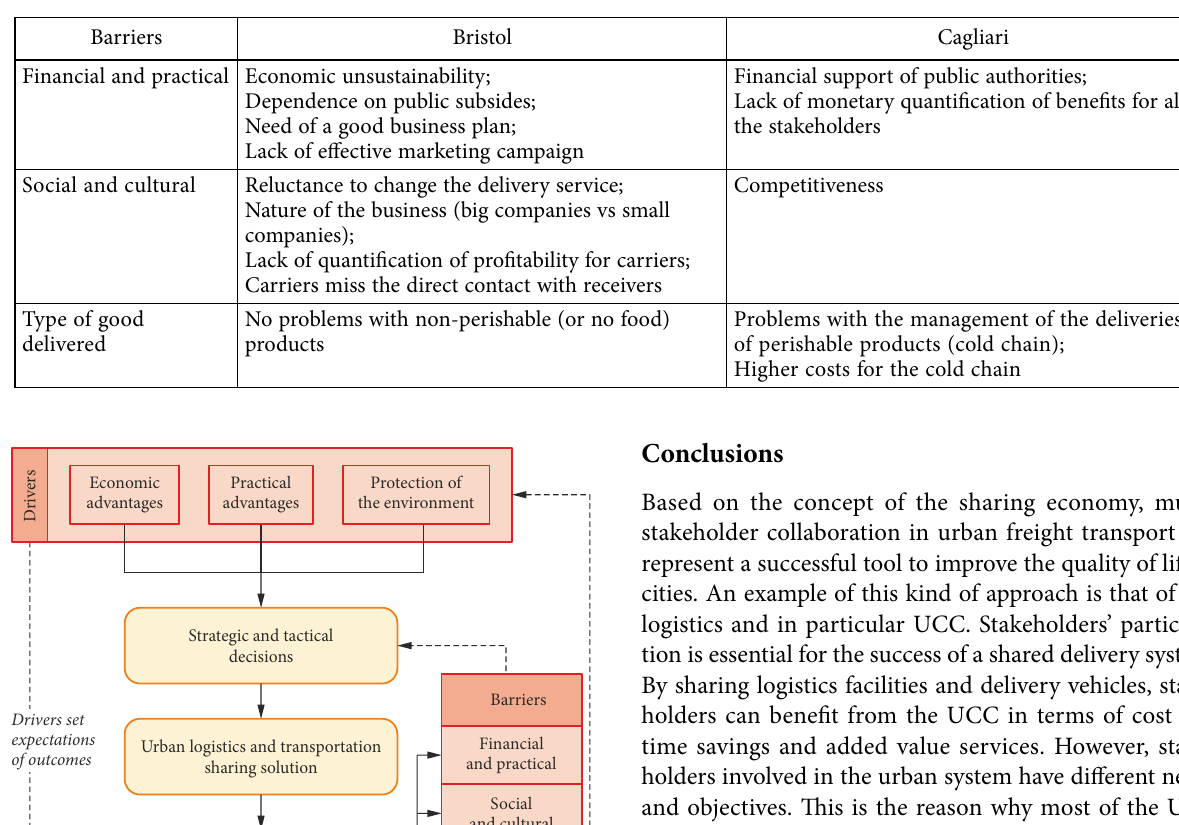
Table 3. Summary of the main barriers highlighted in the cases of Bristol and Cagliari.